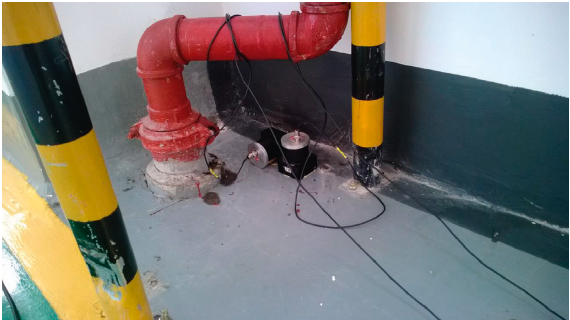
Figure 5: Sensors in industrial building. Figure 6: Sensor in the